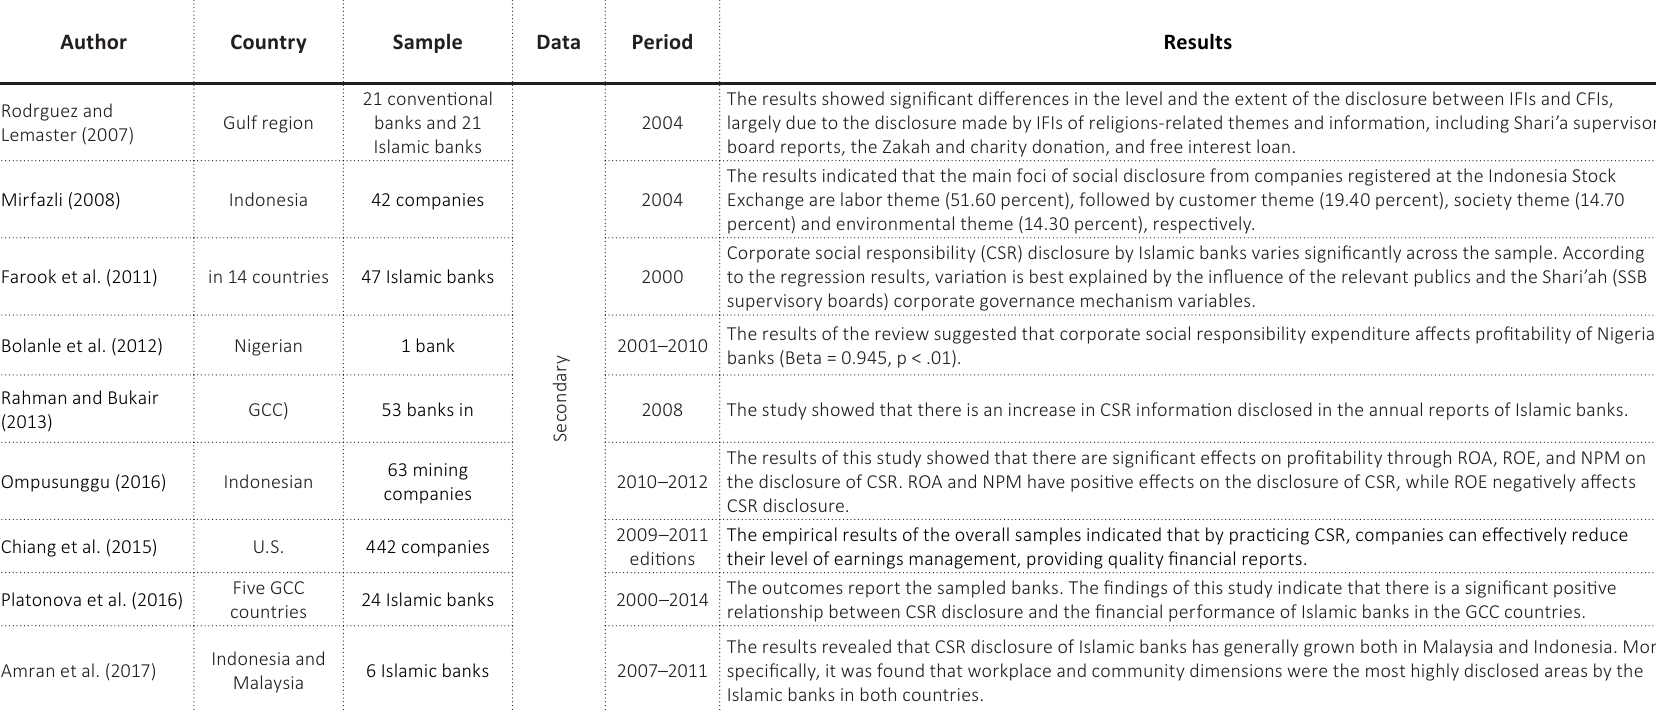
Table 1. Some empirical articles that examined the link between CSD and financial